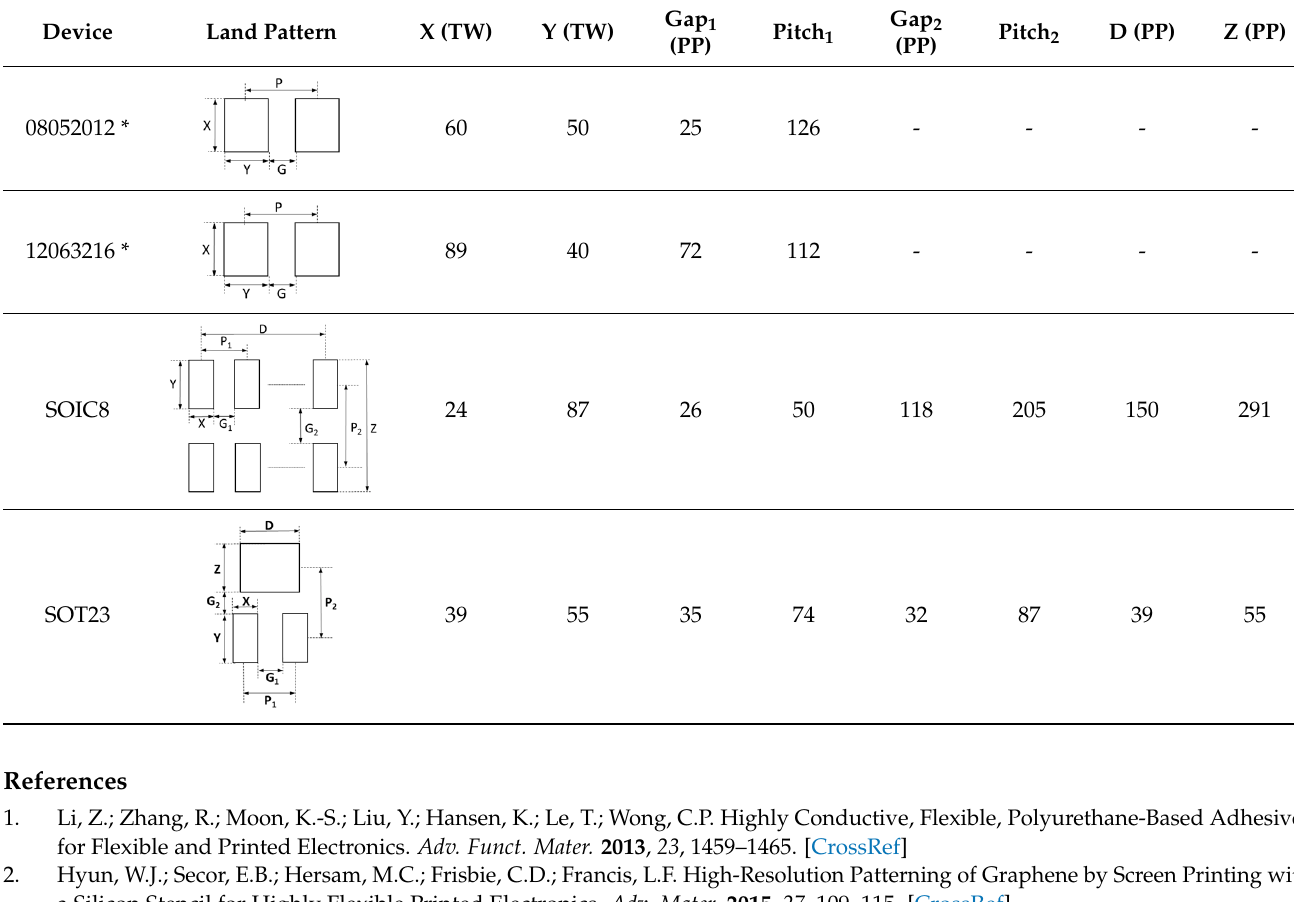
Table A3. SMD recommended land-pattern standard (IPC-SM-782). Component identifier: Impe- Table A3. SMD recommended land ‐ pattern standard (IPC ‐ SM ‐ 782). Component identifier: Impe ‐ Table A3. SMD recommended land ‐ pattern standard (IPC ‐ SM ‐ 782). Component identifier: Impe ‐ Table A3. SMD recommended land ‐ pattern standard (IPC ‐ SM ‐ 782). Component identifier: Impe ‐ Table A3. SMD recommended land ‐ pattern standard (IPC ‐ SM ‐ 782). Component identifier: Impe ‐ rial/metric *. TW: Track width. PP: Pad ‐ to ‐ Pad gap. Units: rial/metric *. TW: Track width. PP: Pad ‐ to ‐ Pad gap. Units: mils.